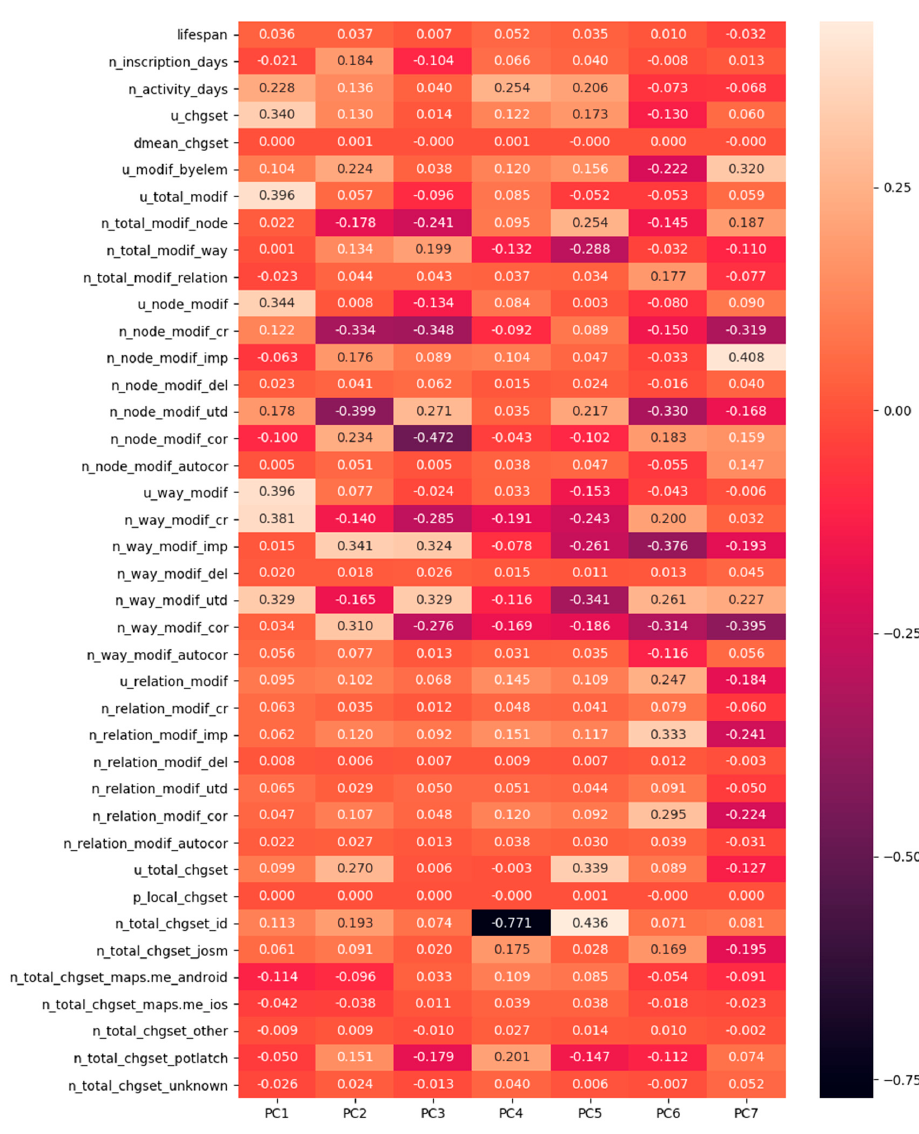
Figure 5. Heatmap of feature contributions on each principal